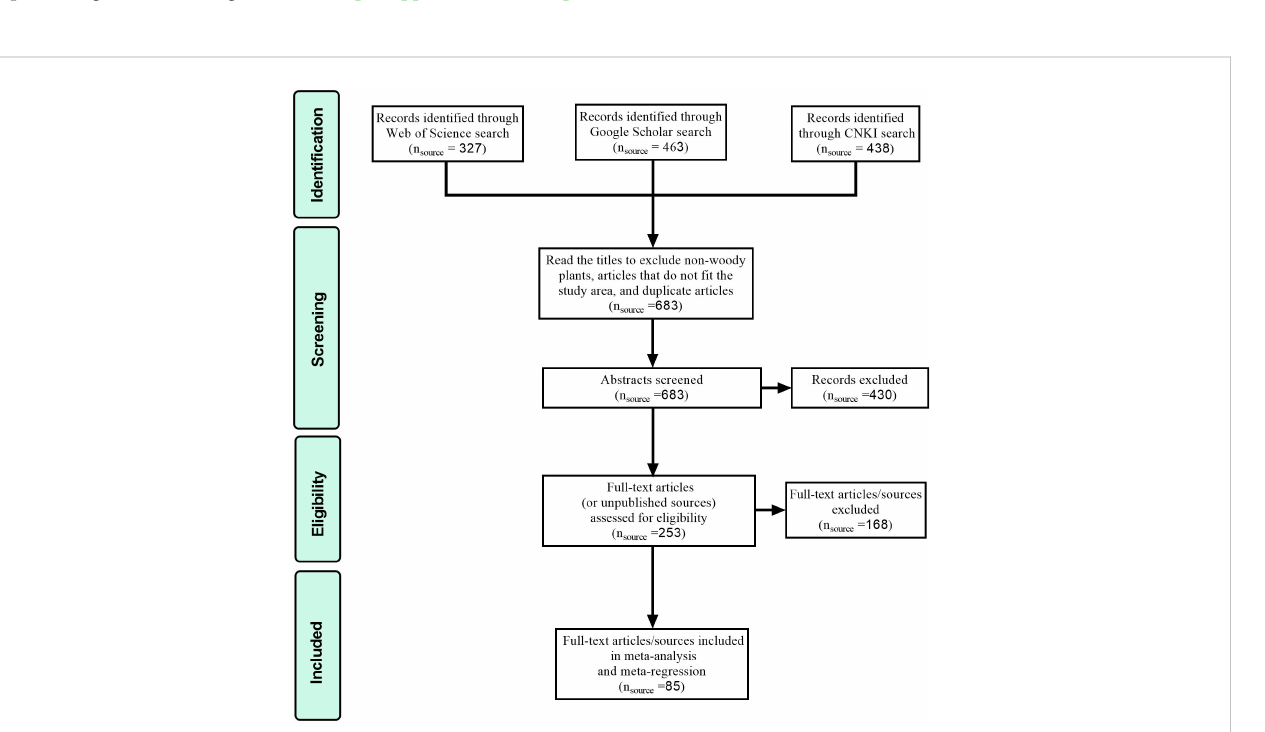
FIGURE 1 PRISMA fl ow chart showing the procedure for selecting